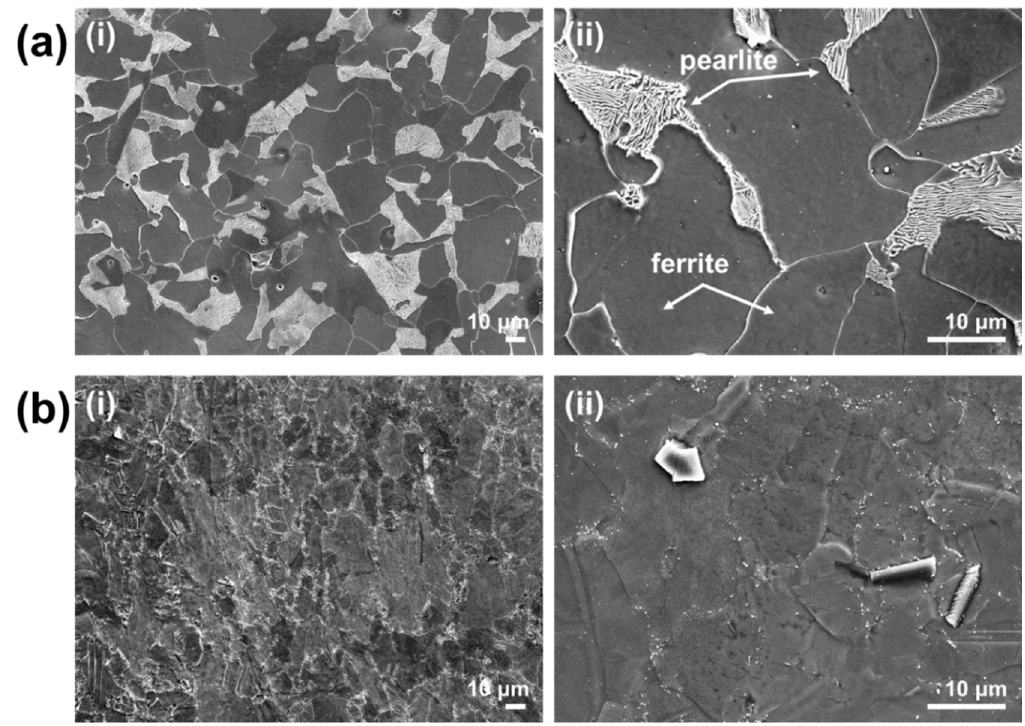
Figure 2. SEM images of the microstructures of ( a ) S400 and ( b ) Fe-based shape memory alloy (FSMA). ( i ) and ( ii ) are the images at low (×500) and high (×2000) magnifications, respectively.